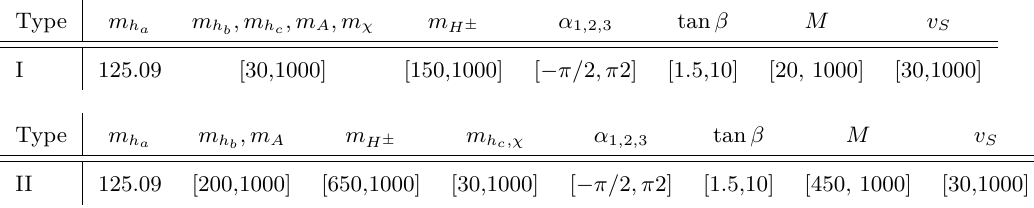
Table 1 . Values of the free parameters for the scan in type I (top) and type II (bottom). Dimensionful parameters are given in